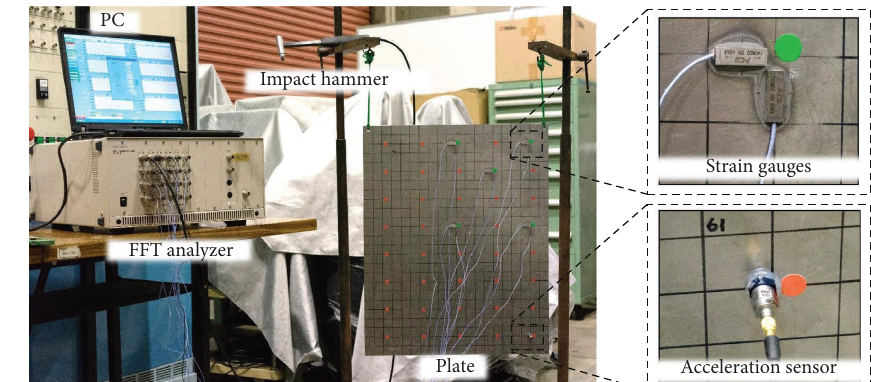
Figure 11: Experiment overview.